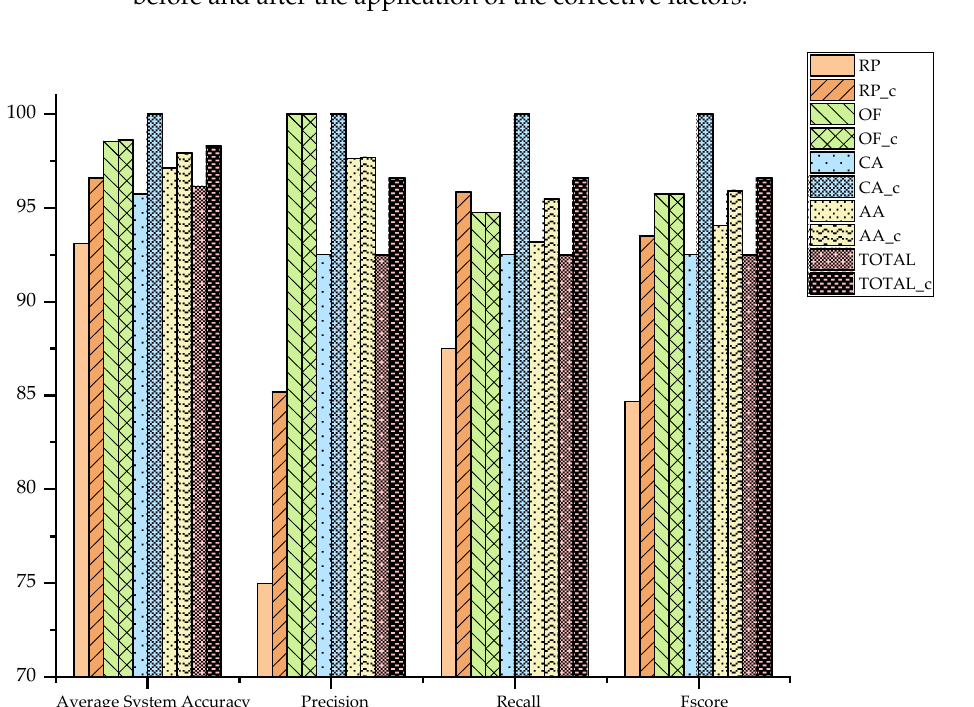
Table 6. TS + VS confusion matrix with the application of correction coefficients.